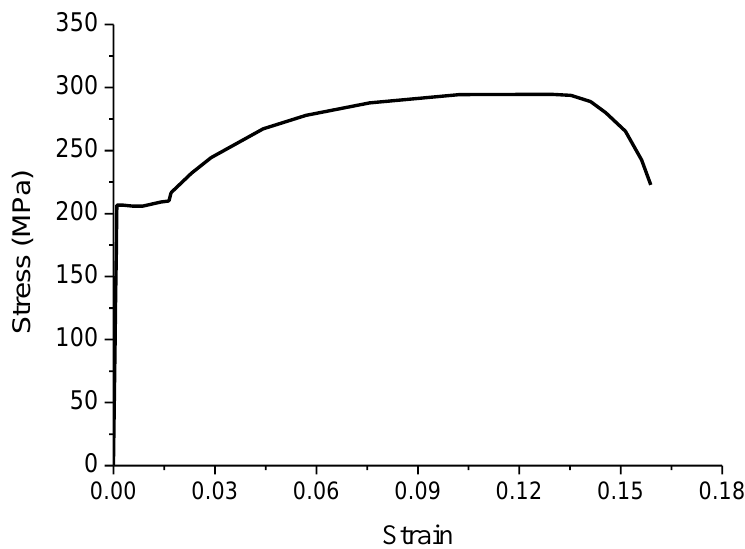
Figure 3. Engineering stress–strain curve of steel Q235 [19]. Table 2. Material properties of steel Q235 [19].